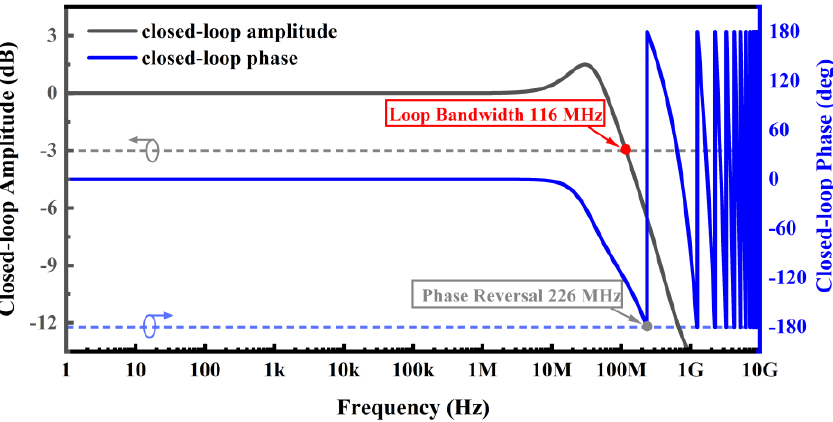
Figure 4. The initial closed-loop amplitude/phase-frequency response of PIC-based heterodyne OPLL. The loop bandwidth is determined by the loop gain and loop delay once F LF ( s )